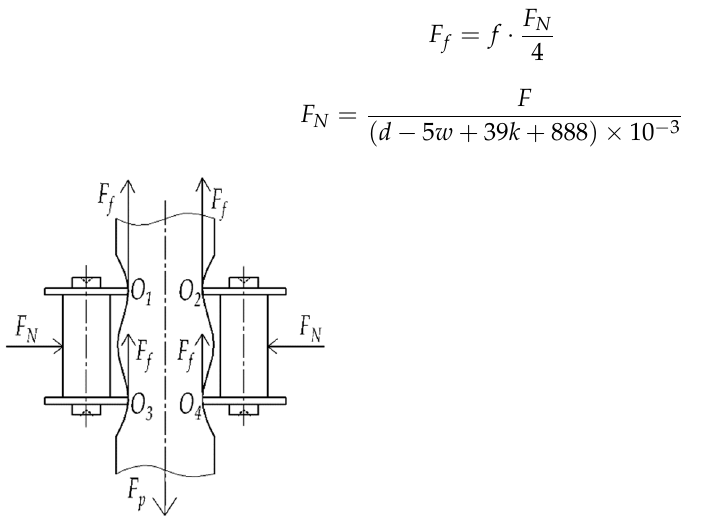
Figure 6. Interaction between clamping chain and corn stalk.